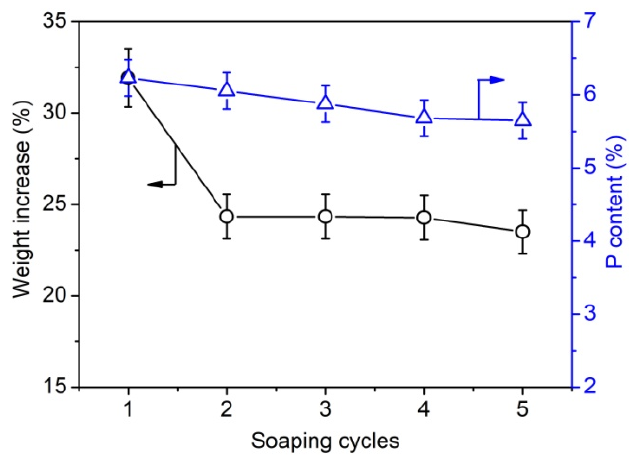
Figure 3. Weight increase percentage and phosphorus content of phosphorylated KF sample prepared using 6 g PA and 6 g urea at 150 °C for 90 min after different cycles of soaping.